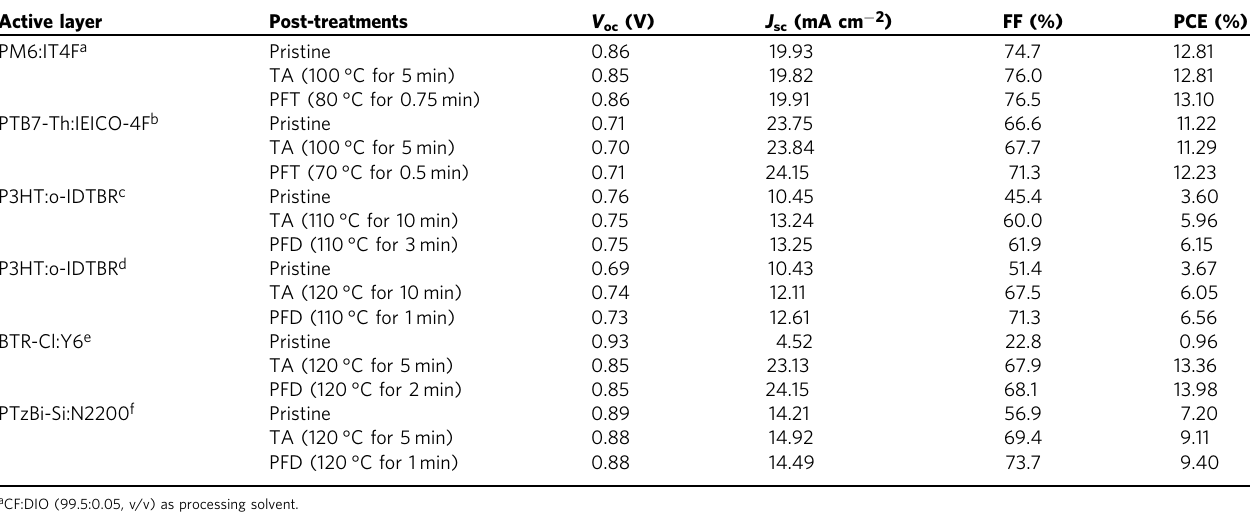
Table 2 The photovoltaic parameters of optimal devices based on various donor/acceptor combinations under the illumination of AM 1.5 G, 100 mW cm − 2